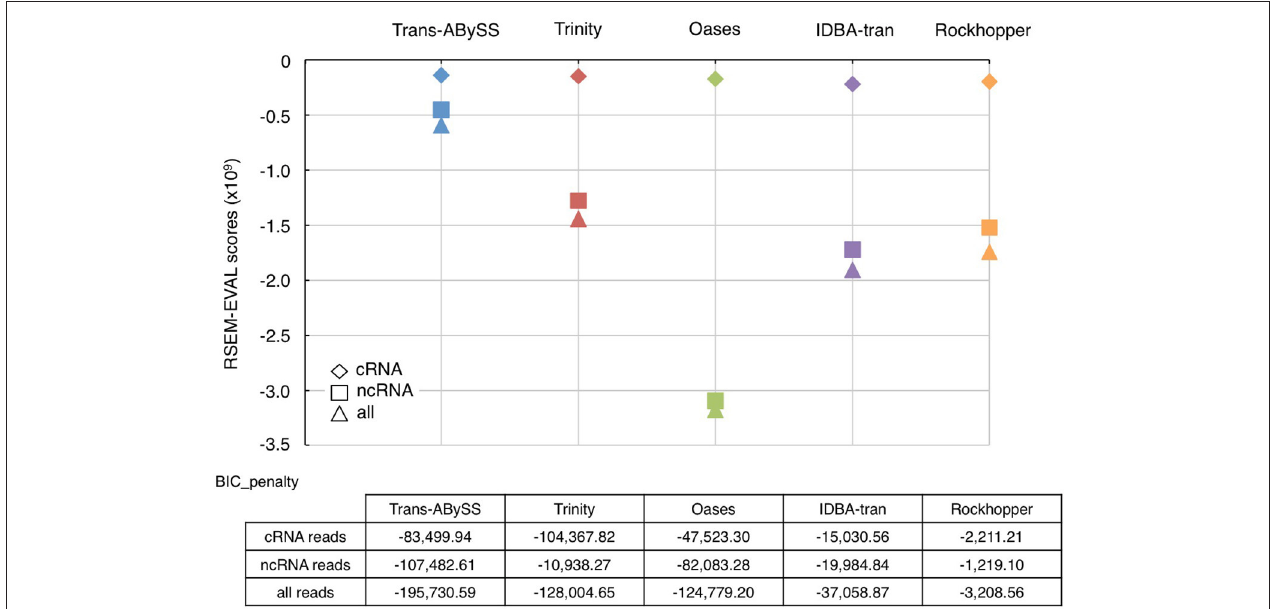
FIGURE 4 | RSEM-EVAL scores and BIC penalties of metatranscriptomic assemblies. The RSEM-EVAL scores computed for the assemblies generated from cRNA (diamond), ncRNA (square), and all RNA (triangle) reads by the five novo transcriptomic assemblers were indicated using the same color scheme as in Figure 1 . The closer is the RSEM-EVAL score to zero, the better the assembly. The complexity of these assemblies was reflected by the Bayesian information criterion (BIC) penalty score. An assembly’s complexity is assumed to be inversely proportional to its